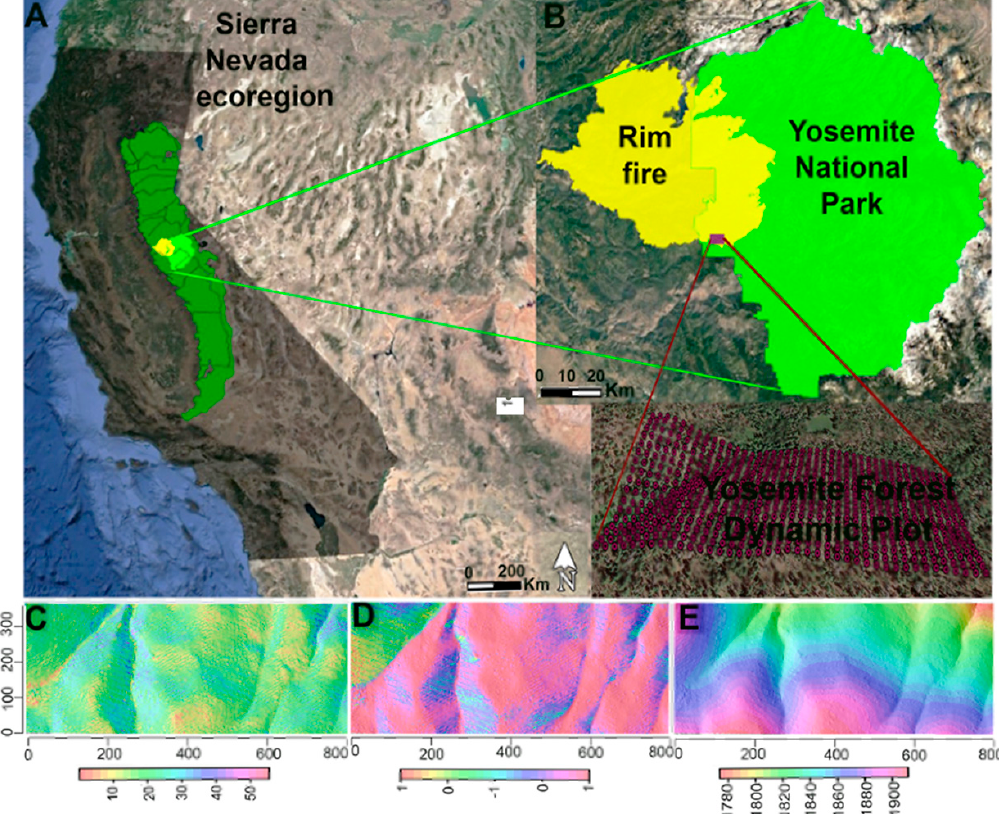
Figure 1. Locations of Yosemite National Park and Yosemite Forest Dynamic Plot (YFDP) in California ( A , B ). Topographic maps of the 25.6 ha plot including slope (°) ( C ), aspect (cosine of aspect) ( D ), and elevation (m) ( E ). Imagery from Google Earth 2020 [ 51 ].